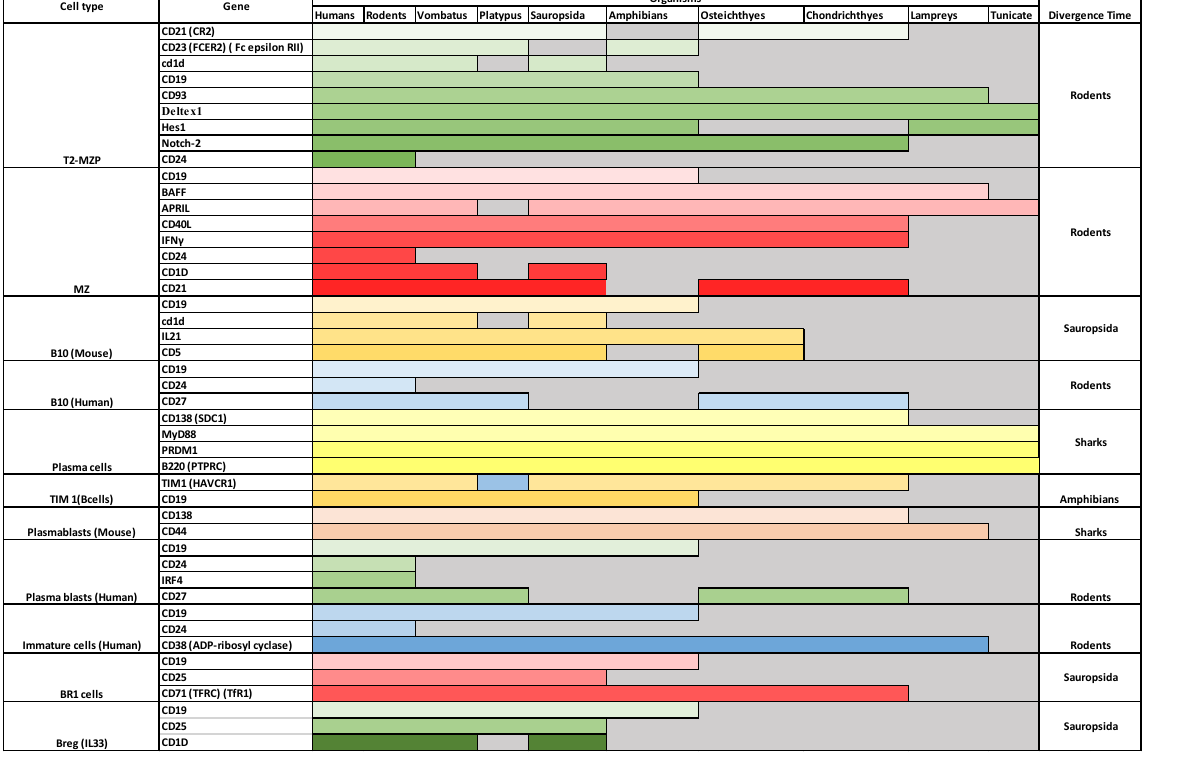
Figure 5. Evolution of known Breg markers. B cell emergence seems to have predominantly emerged during fish divergence. In contrast, Bregs’ current markers indicate a continuum of divergence. Each type of cell is represented by a different color shade. To produce these results, we followed a classical phylogenetic approach by downloading human proteins from NCBI (last access 5 of May 2022) and then blasting them against rodents, Vombatus, Platypus, Sauropsida, Amphibians, Osteichthyes (e.g., bony fish), Chondrichthyes (e.g., cartilaginous fish), Lamprey and Tunicate